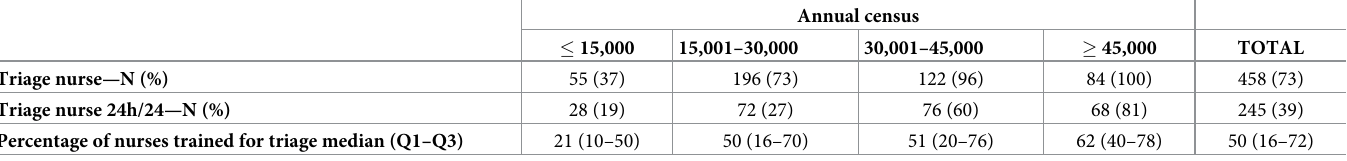
Table 3. Characteristics of triage organization depending on the number of ED visits per